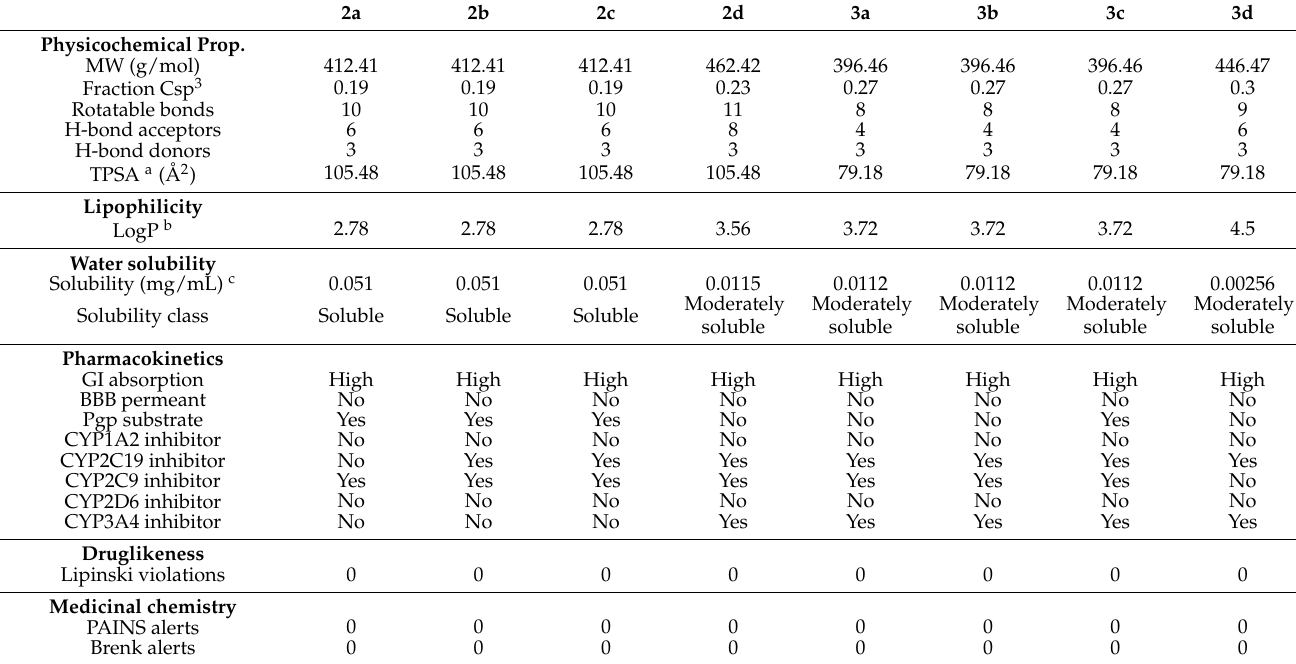
Table 2. Predicted pharmacokinetics and drug-like properties of compounds 2a – d and 3a – d .